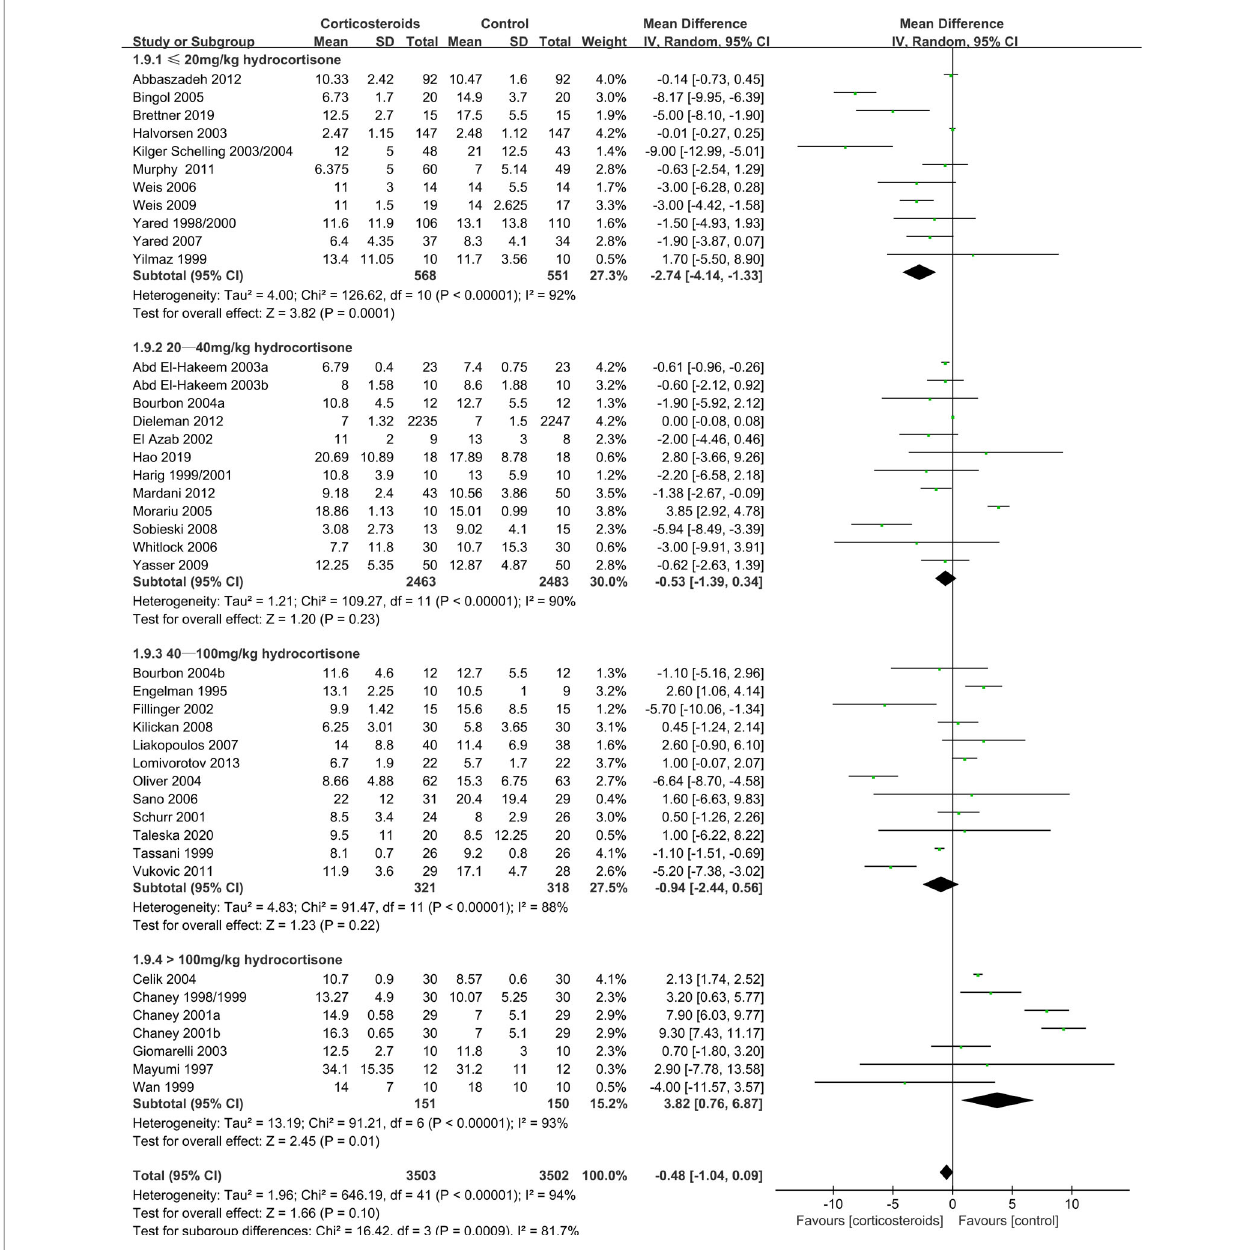
FIGURE 5 | Impact of corticosteroids on mechanical ventilation time (hours)